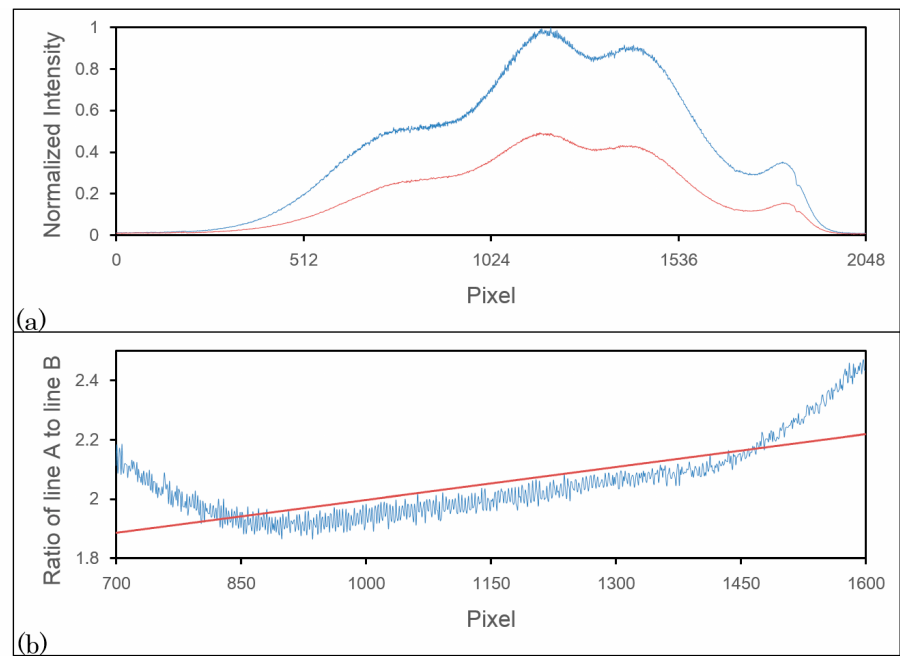
Figure 2. ( a ) The light source spectra received by line A (blue) and line B (red); the red line intensity is about half that of the blue line, and the shapes of the two lines are very similar; ( b ) The ratio of spectra received by line A to that by line B from the 700th pixel to 1600th pixel (blue), and its linear fitting line